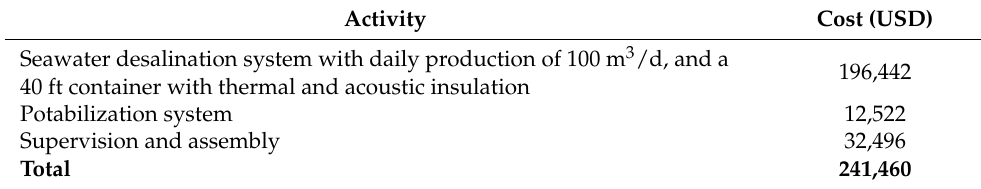
Table 9. Summary of CAPEX of the seawater desalination